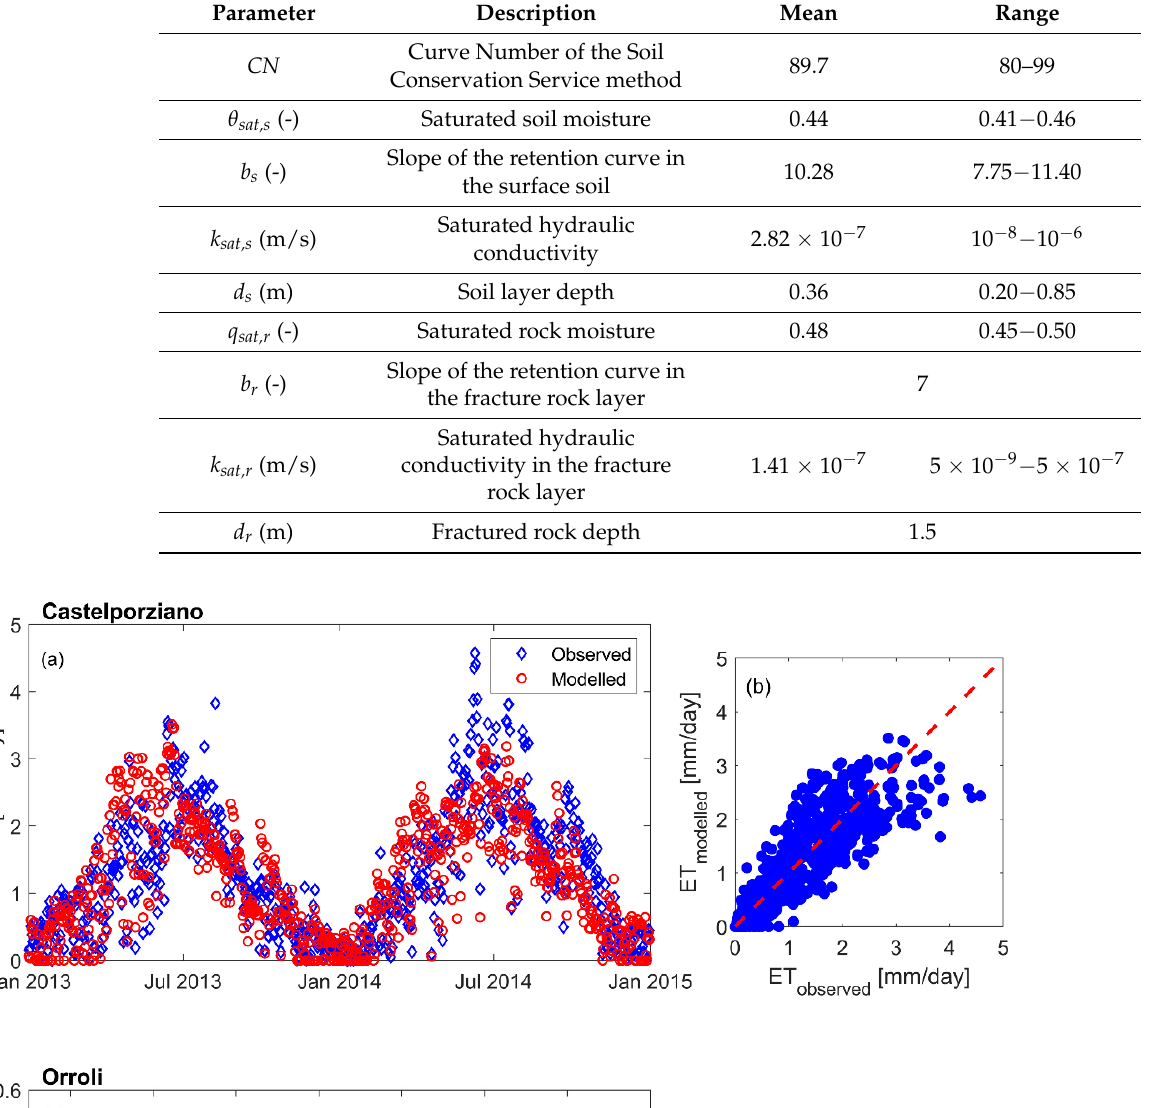
Table 3. Soil-related parameters of the model.